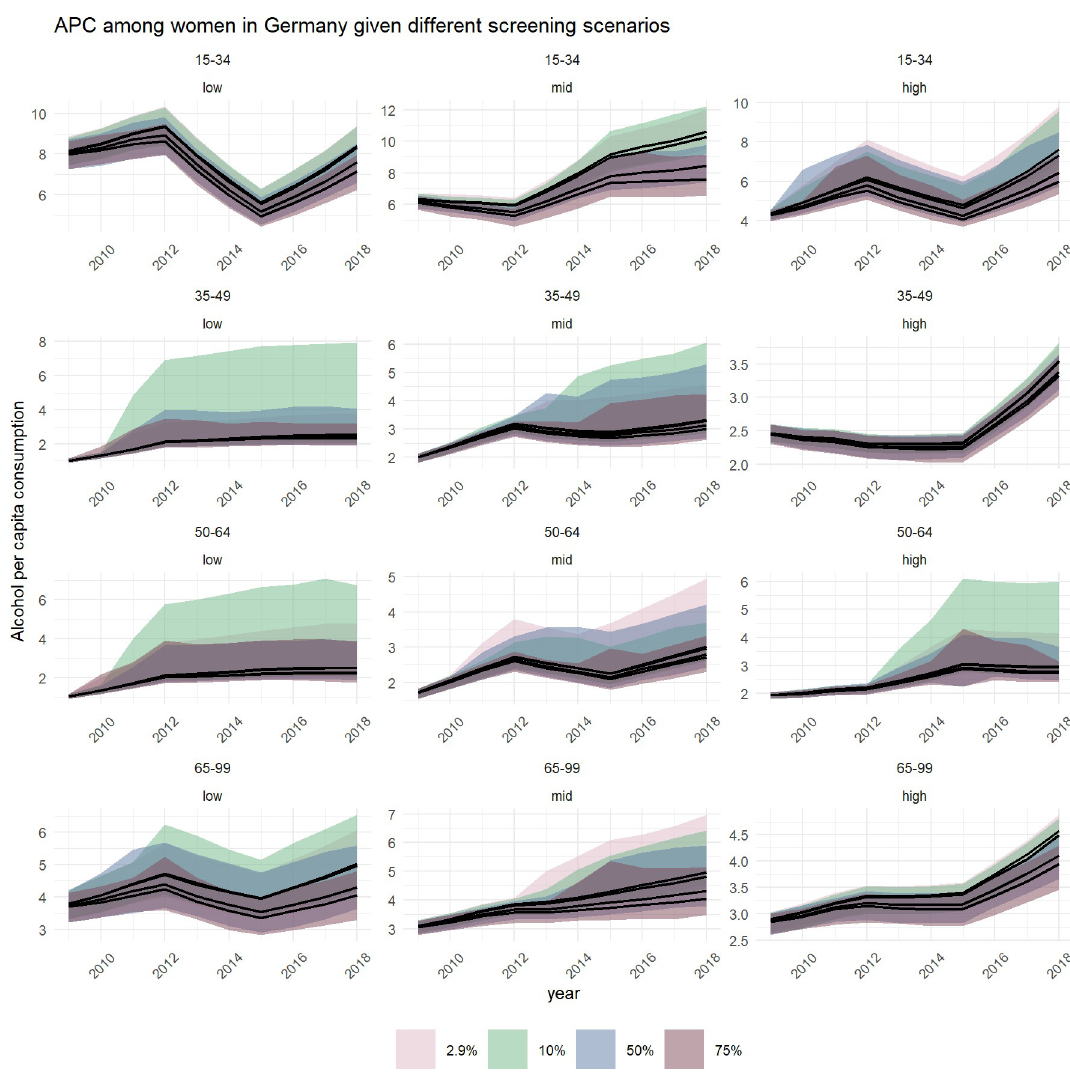
Fig 4. Trends of alcohol per capita consumption (in litres pure alcohol) among German women between 2009 and 2018, stratified by age (horizontal) and education status (vertical), by annual screening coverage (coloured shade). In each facet, the upper line represents the baseline scenario with a screening rate of 2.9%. The increasing coverage rate is represented by all lower lines with the second highest representing 10%, the third highest representing 50%, and the lowest representing 75% screening coverage